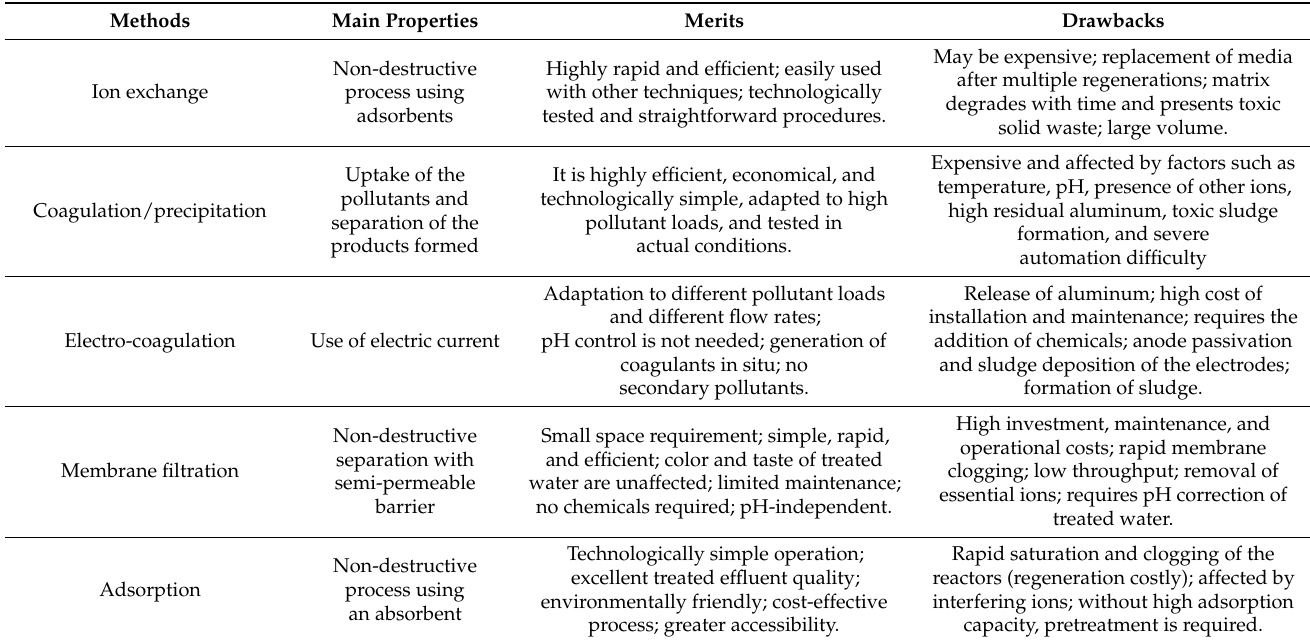
Table 1. Comparison of standard defluoridation